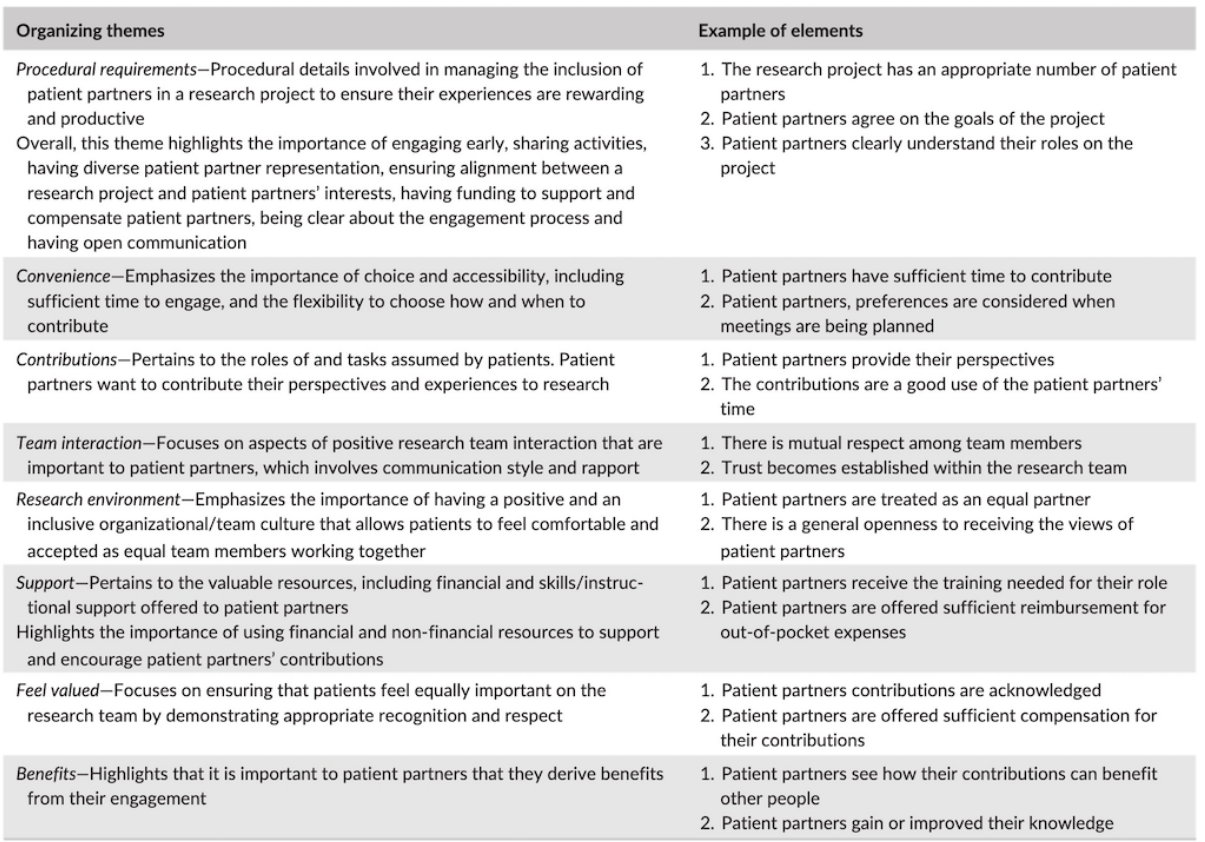
Figure 1. Organizing themes of the Patient Engagement in Research Framework with examples of corresponding elements (reprinted with permission from authors)